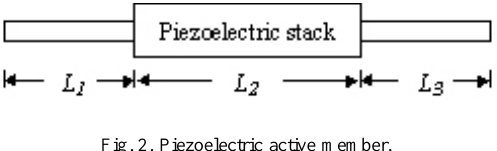
Fig. 2. Piezoelectric active